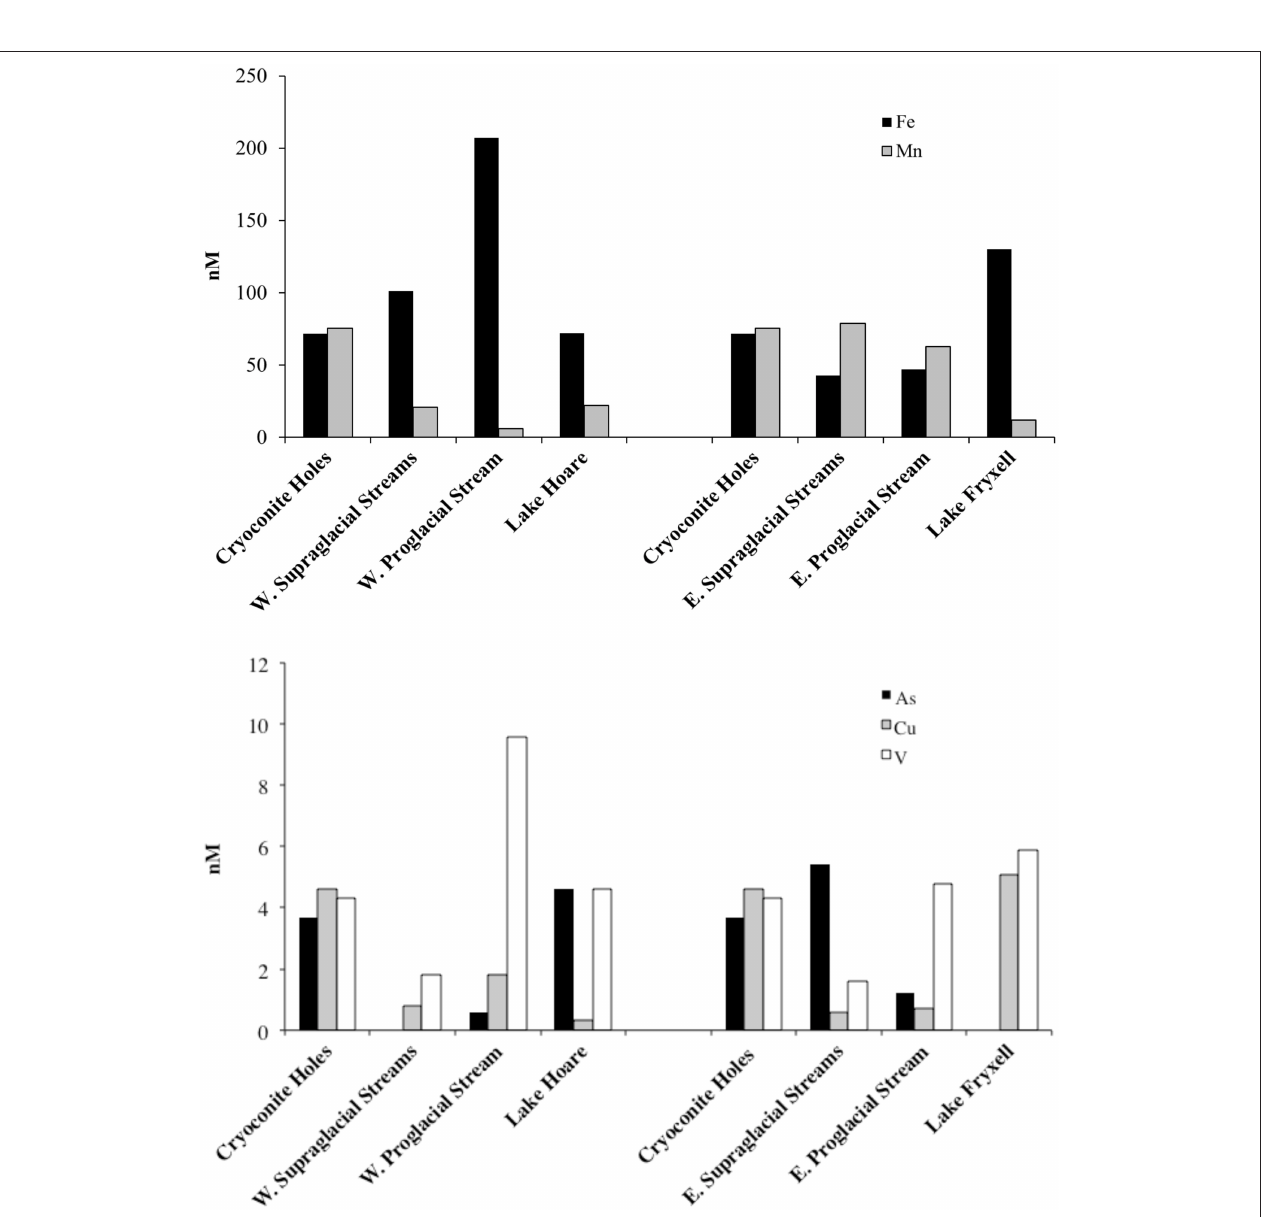
FIGURE 3 | (Top) Median dissolved Fe and Mn concentrations (nM) in cryoconite holes, supraglacial streams, proglacial streams, and lakes. Note that western waters are presented on the left and eastern waters are on the right. (Bottom) Median dissolved As, Cu, and V concentrations (nM) in cryoconite holes, supraglacial streams, proglacial streams, and lakes. Note As was not measured in Lake Fryxell.